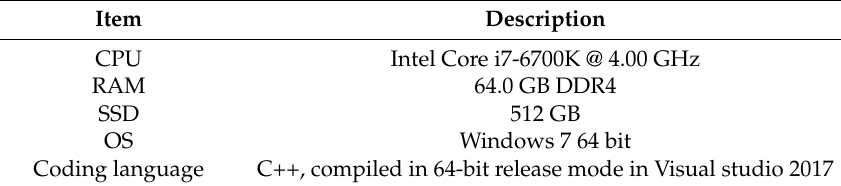
Table 2. Specifications of the computing environments.